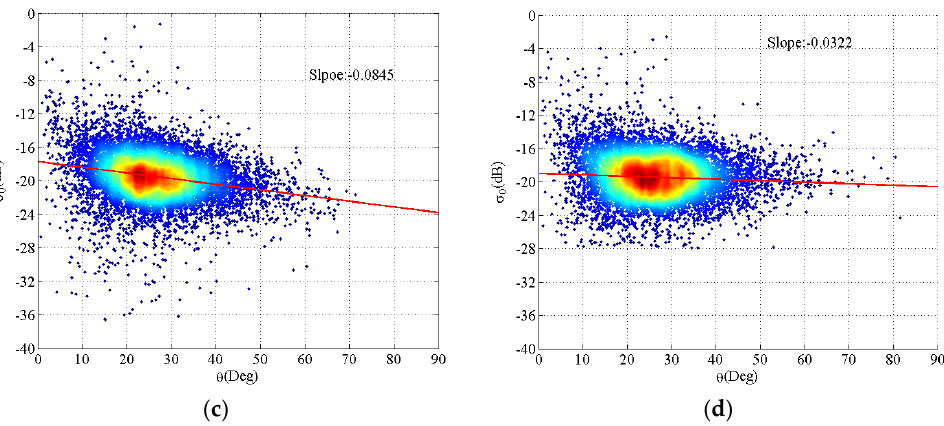
Figure 7. Comparison of backscattering coefficient between measurement data and experiment result on the ALOS PALSAR data set for Genhe: ( a ) experiment data; ( b ) RD based geometric correction; ( c ) radiometric normalization correction; and ( d ) backscatter optimization radiometric correction. Table 3. Backscatter coefficient comparison of different terrain correction method on the ALOS PALSAR data set in Genhe.